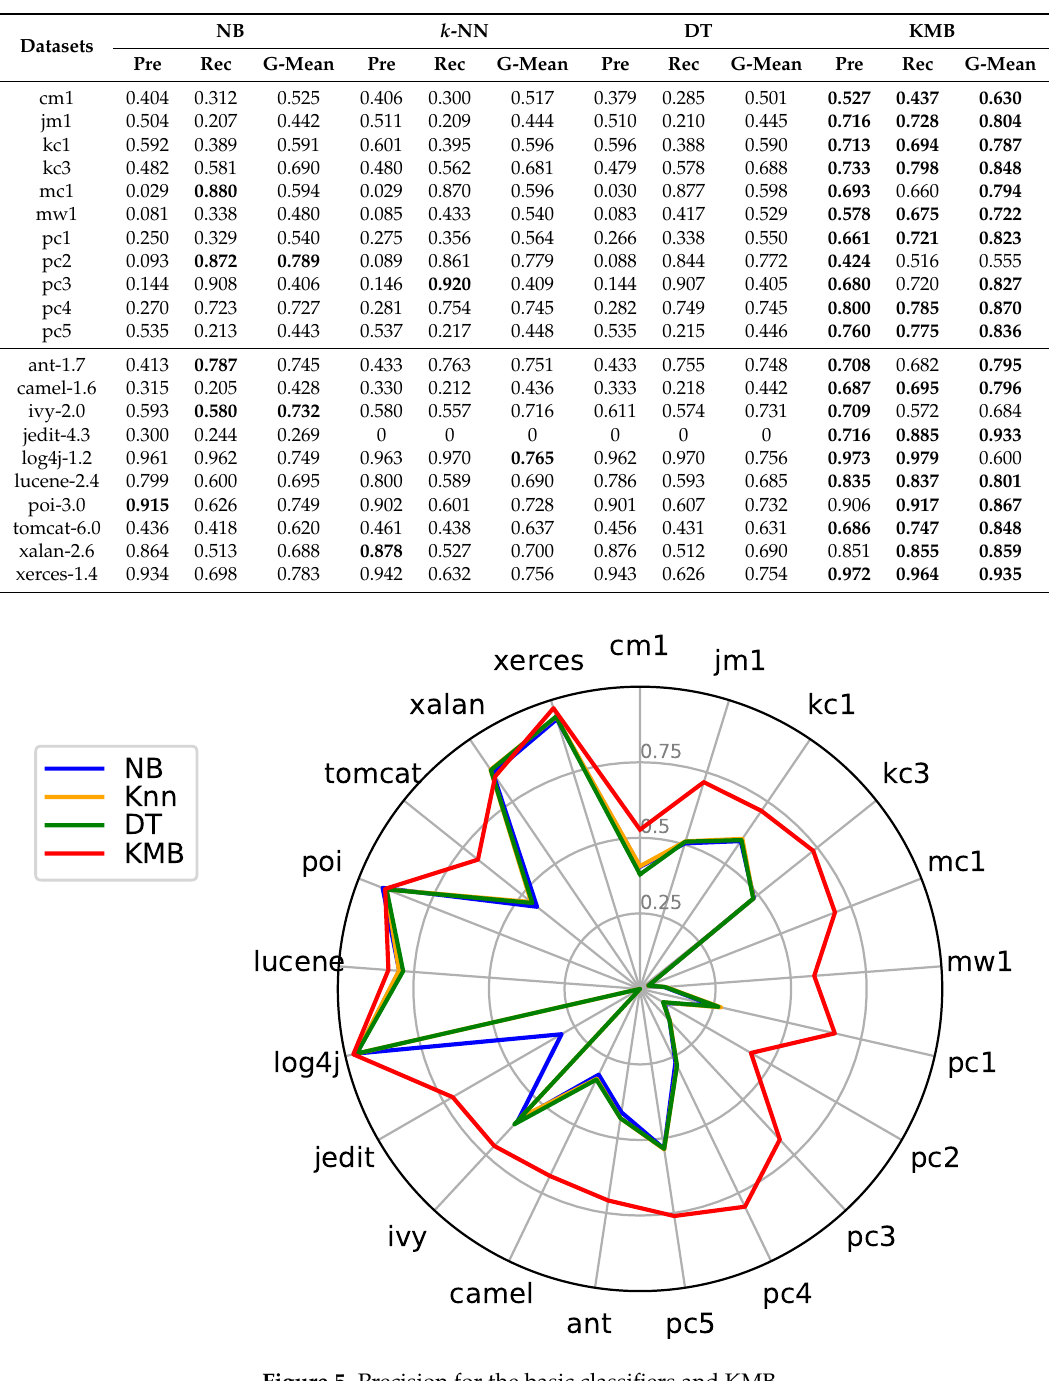
Figure 5. Precision for the basic classifiers and